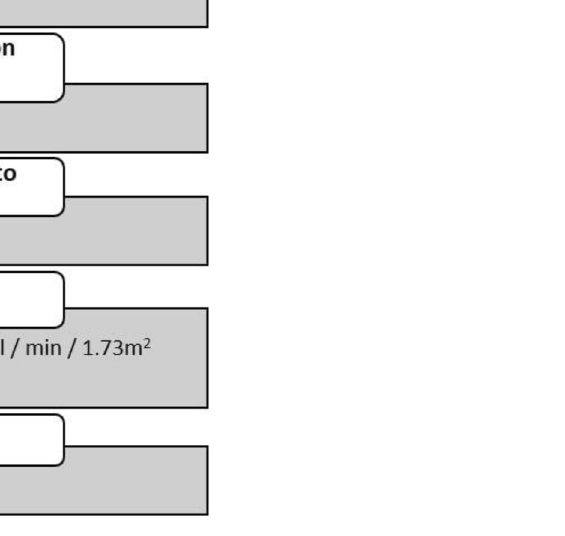
Figure 1. Flow diagram of the study